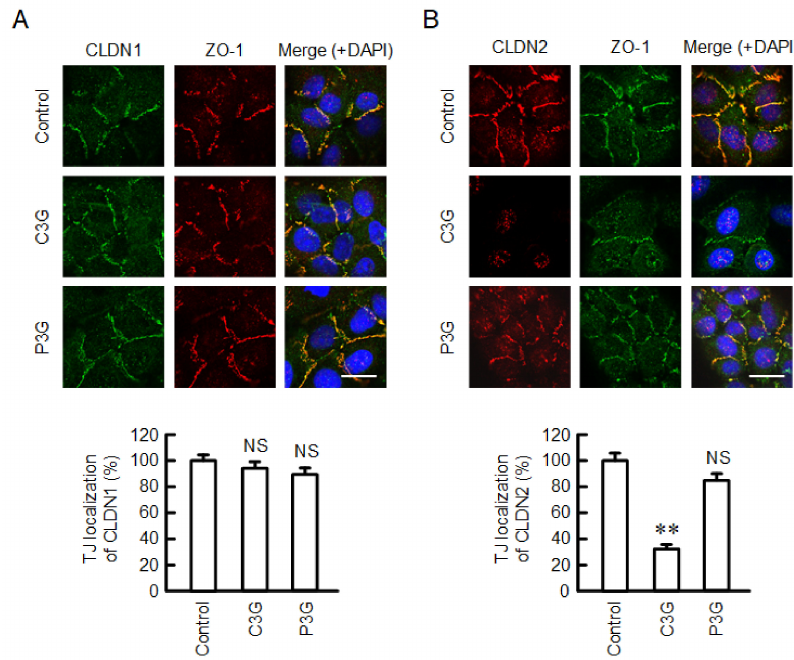
Figure 2. Effects of anthocyanins on the cellular localization of CLDN1 and CLDN2. Cells cultured on cover glasses were incubated in the absence (control) and presence of 50 µ M C3G or P3G for 24 h. ( A ) The cells were stained with anti-CLDN1 (green), anti-ZO-1 (red), and nuclear marker DAPI (blue). ( B ) The cells were stained with anti-CLDN2 (red), anti-ZO-1 (green), and DAPI (blue). Merged images are shown in the right panel. The scale bar represents 10 µ m. The TJ localizations of CLDN1 and CLDN2 are shown as percentage of control ( n = 132-220 cells). ** p < 0.01 and NS p > 0.05 compared with